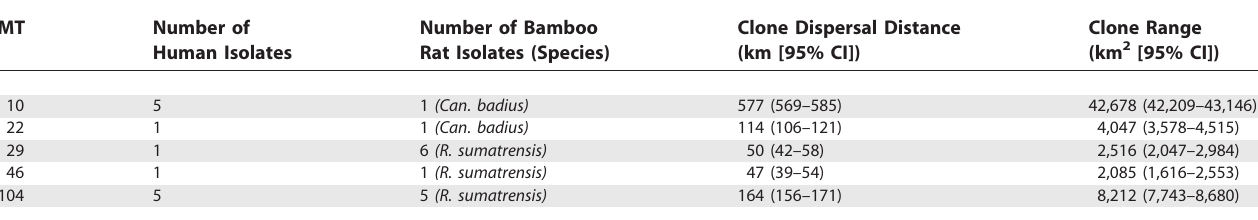
Table 1. Dispersal Distance and Clone Range for MTs Common to Both Humans and Bamboo Rats